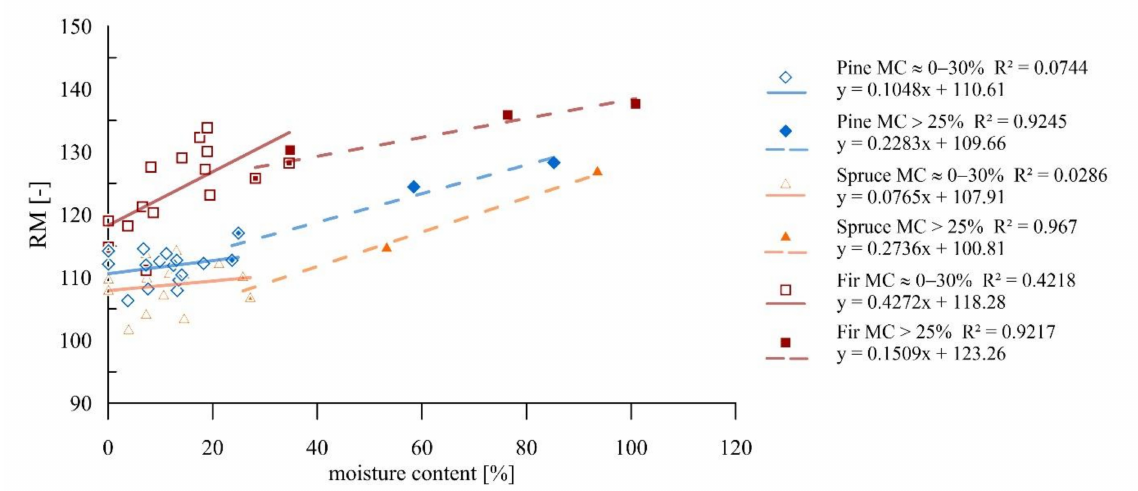
Figure 15. Resistance drilling tests for samples of different moisture